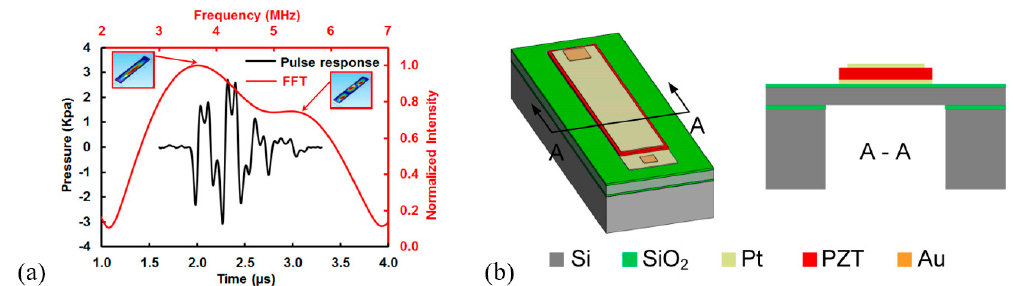
Figure 25. ( a ) Measured acoustic pressure of a broadband pMUT demonstrates a 97% fractional bandwidth with overlapping modes (Reproduced with permission from IEEE [155]). ( b ) Schematic design of a rectangular multifrequency pMUT (Reproduced with permission from IEEE [156]).